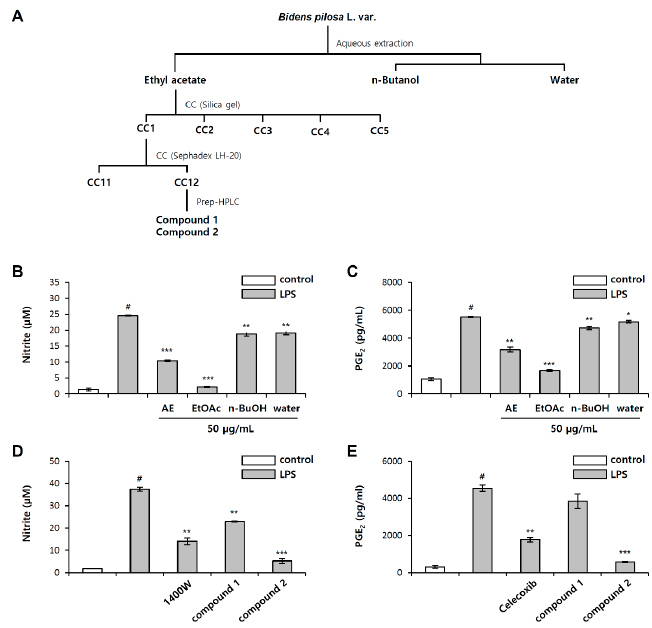
Figure 1. ( A ) Bioassay-guided isolation scheme of isookanin from B. pilosa . Effect of the B. pilosa aqueous extract fractions on ( B ) nitric oxide (NO), and ( C ) prostaglandin E2 (PGE 2 ) production in lipopolysaccharide (LPS)-induced RAW 267.4 cells. Effect of compounds 1 and 2 on ( D ) NO, and ( E ) PGE 2 production in LPS-induced RAW 267.4 cells. The results are mean ± standard deviation (SD) ( n = 3). # p < 0.01 vs. LPS-untreated control. * p < 0.05, ** p < 0.01, and *** p < 0.001 vs. LPS-treated control. AE: aqueous extract; EtOAc: ethyl acetate partition; n-BuOH: n -butanol partition; Water: water partition. Molecules 2021 , 26 , x FOR PEER REVIEW